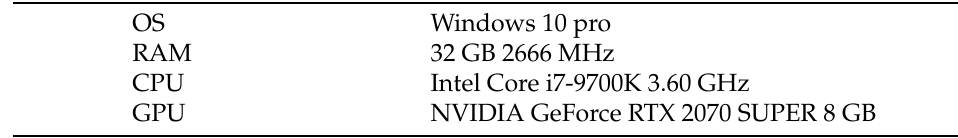
Table 1. Experimental Environment.